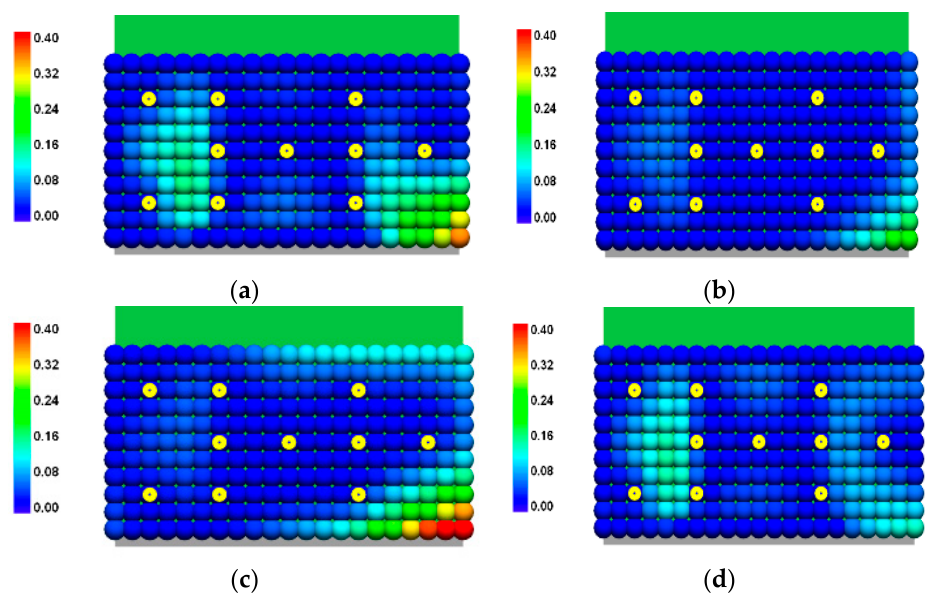
Figure 7. Residual gap fields after fastener installation. ( a ) G 1 (mm). ( b ) G 2 (mm). ( c ) G 3 (mm). ( d ) G 4 (mm).